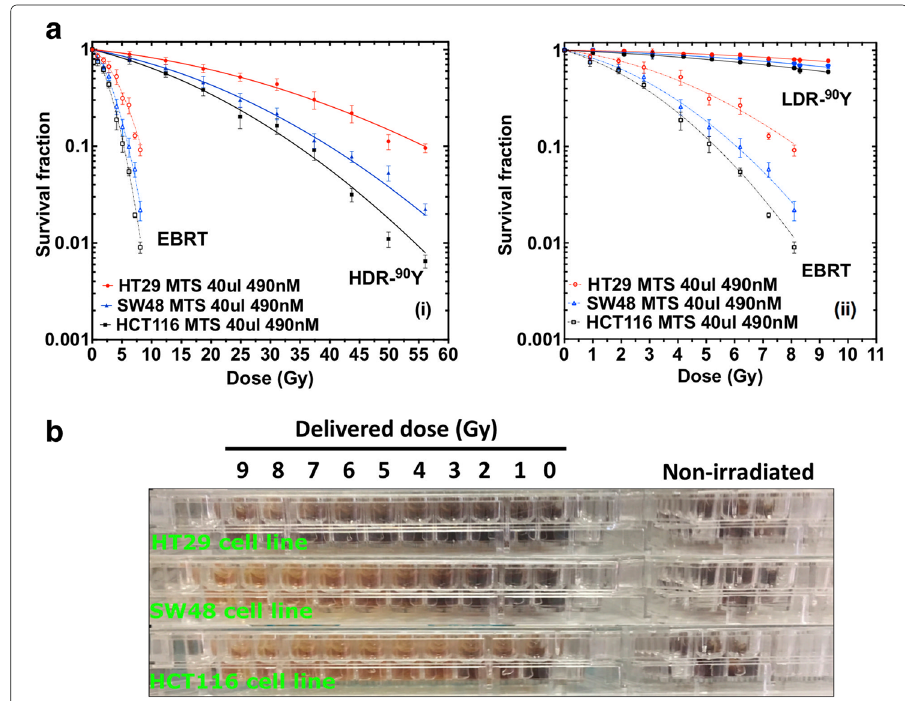
Fig. 6 a Cell survival as a function of delivered dose for EBRT and (i) HDR– 90 Y RNT and (ii) LDR– 90 Y RNT, b MTS colorimetric dose response of EBRT at different delivered acute doses, darker brown colour represents higher number of viable cells in each well